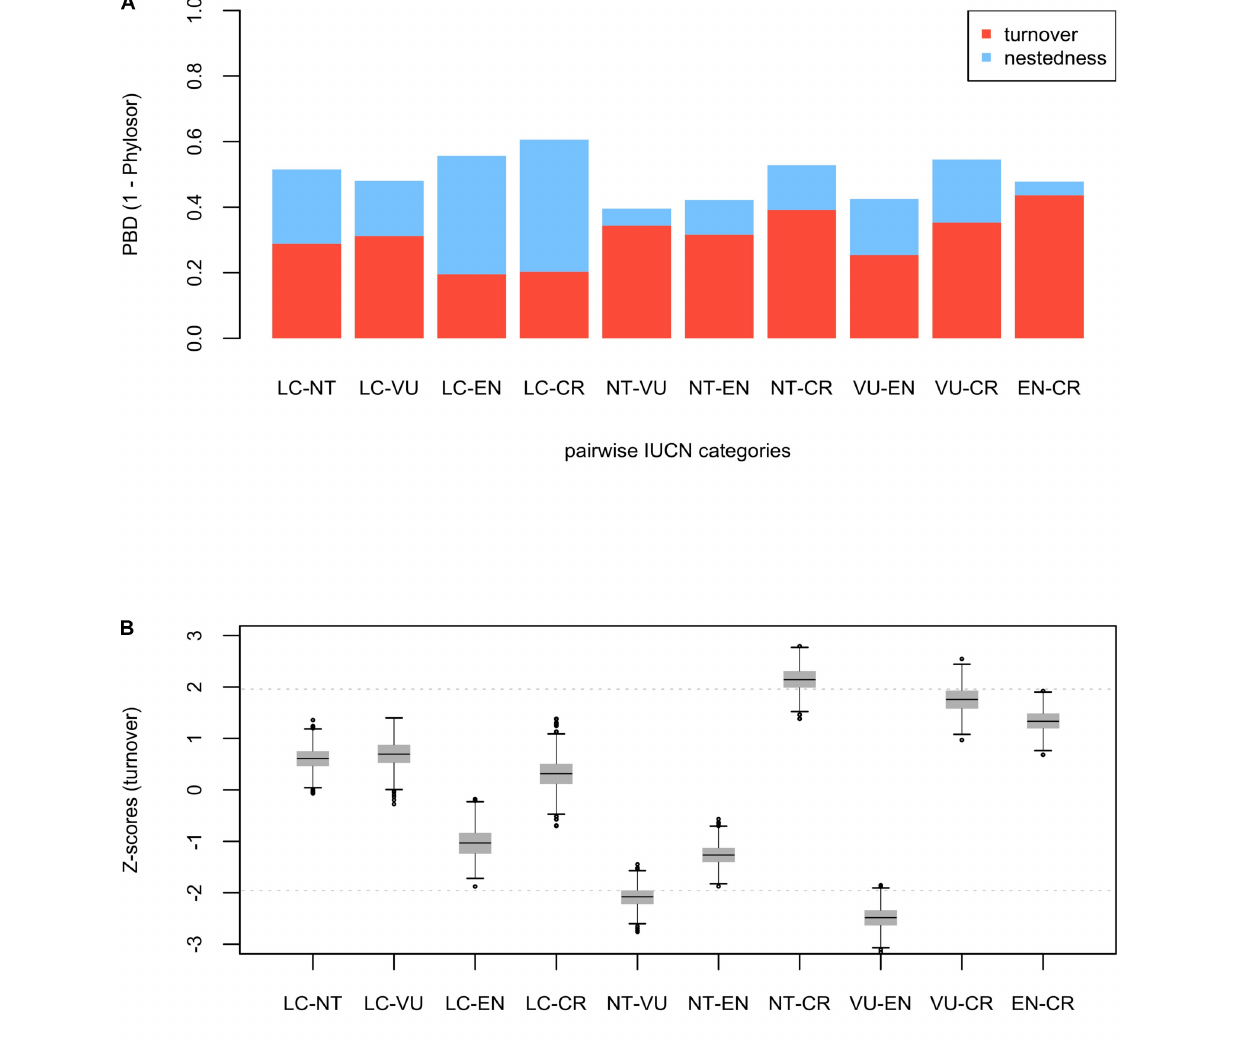
Frontiers in Ecology and Evolution |